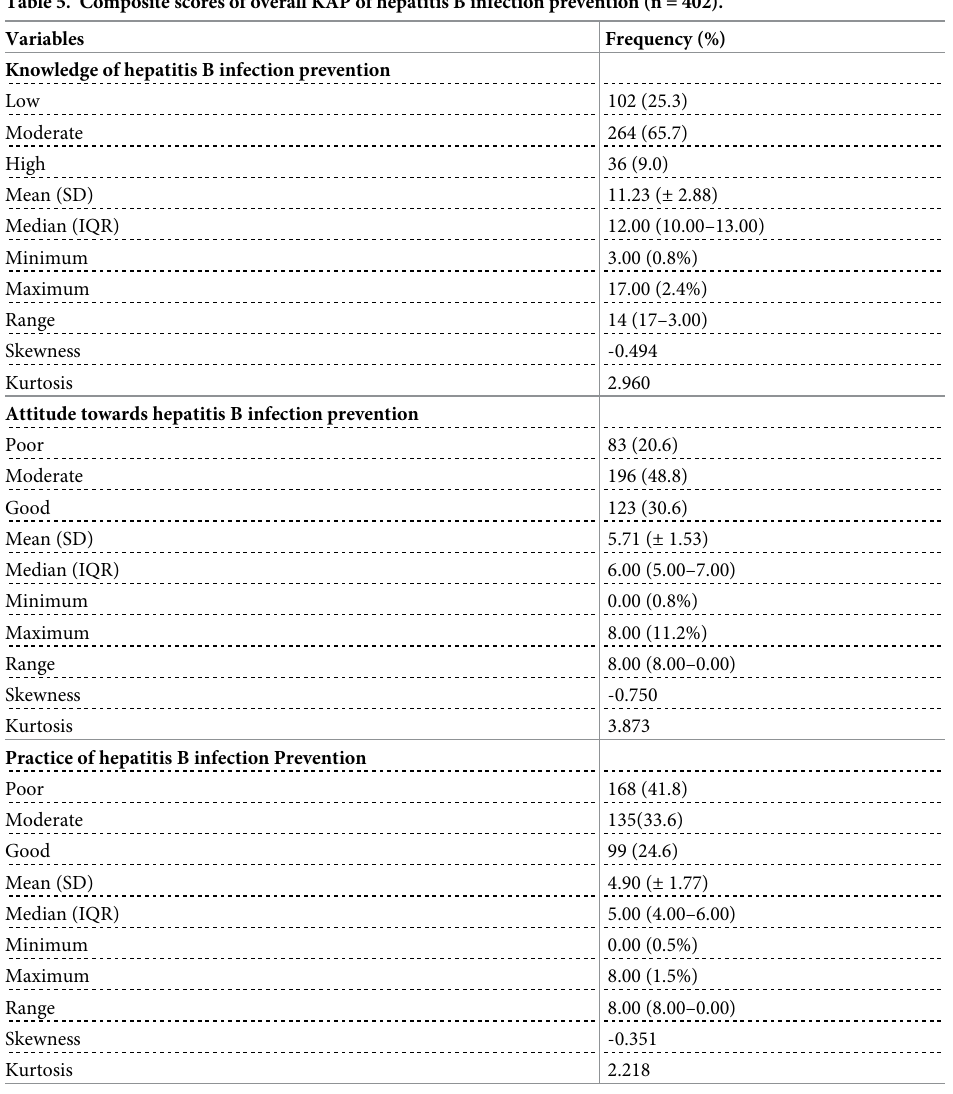
Table 5. Composite scores of overall KAP of hepatitis B infection prevention (n =